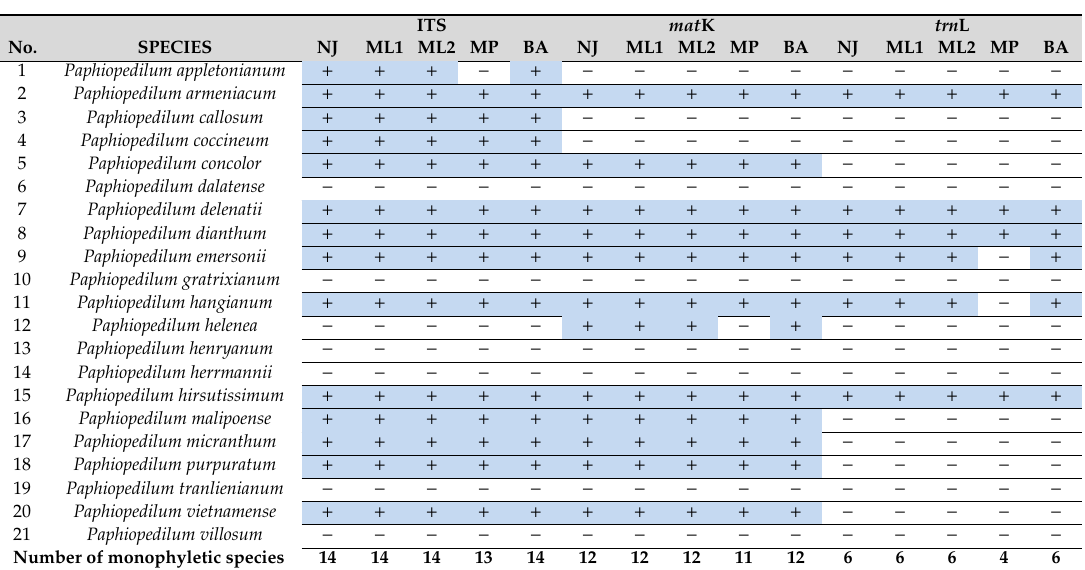
Table 4. Species resolution of di ff erent barcodes on Vietnamese Paphiopedilum populations using di ff erent bioinformatic tools in di ff erent